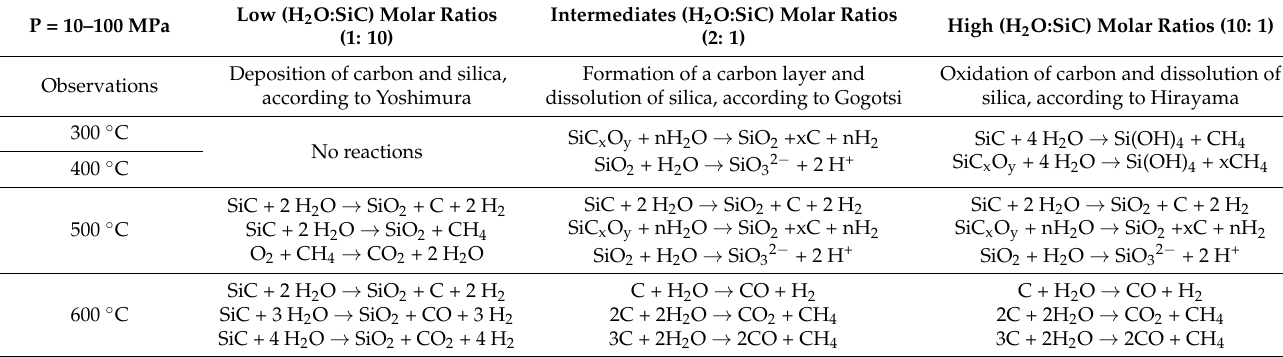
Table 8. Competition between the hydrothermal oxidation and hydrolysis of crystalline silicon carbide, oxycarbidic and silica phases by water depending on the temperature and the H 2 O: SiC molar ratios. Extracted from References [92,93,126]. P = 10–100